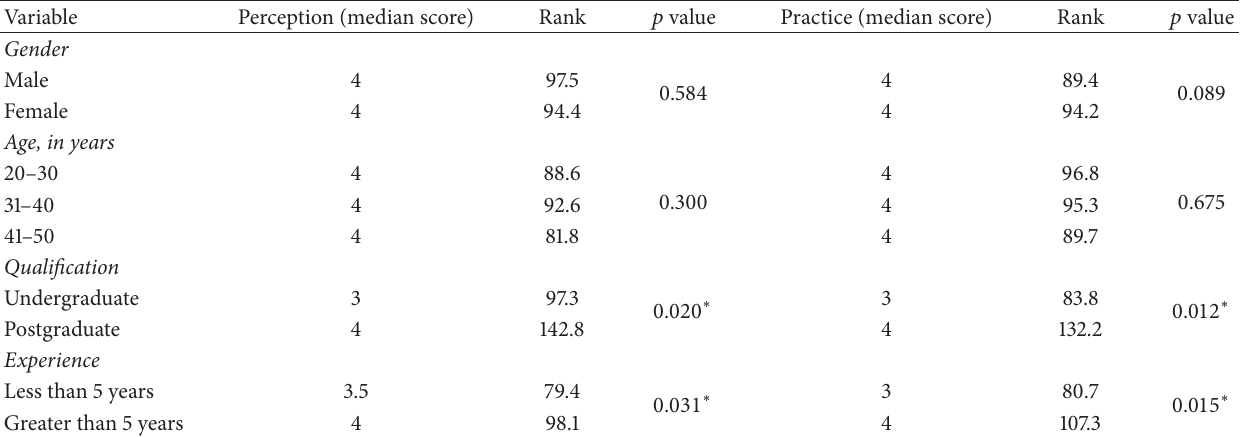
Table 4: Median perception and practice scores of participants regarding AMS ( 𝑁 = 389